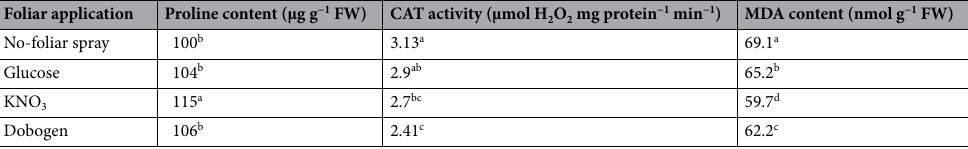
Table 6. Mean comparisons for the effects of 2 g L −1 glucose, 2 g L −1 KNO 3, and 2% Dobogen foliar application on TSS, proline and MDA content, and catalase activity of Tanacetum balsamita plants grown hydroponically in perlite. Significant differences among treatments are indicated by different Latin letters.